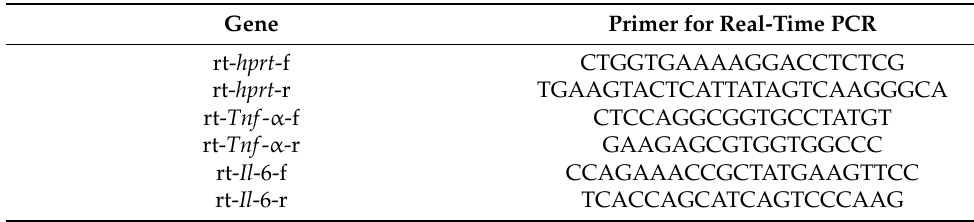
Table 3. Primers used in this